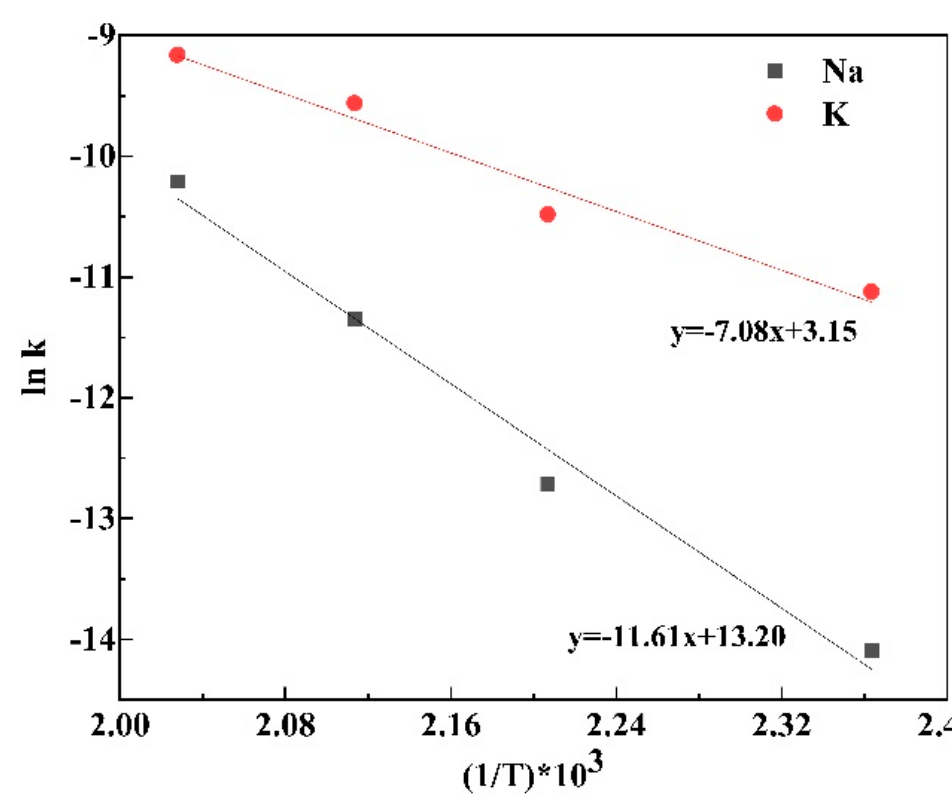
Figure 10. Fitting line of the Arrhenius equation.